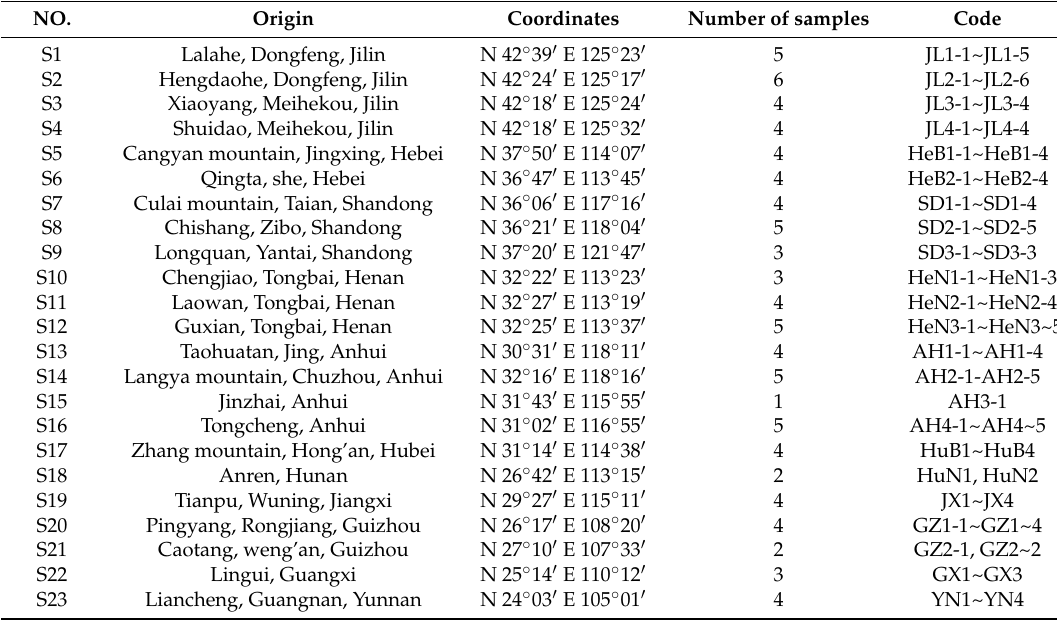
Table 7. PR samples collected from different regions of